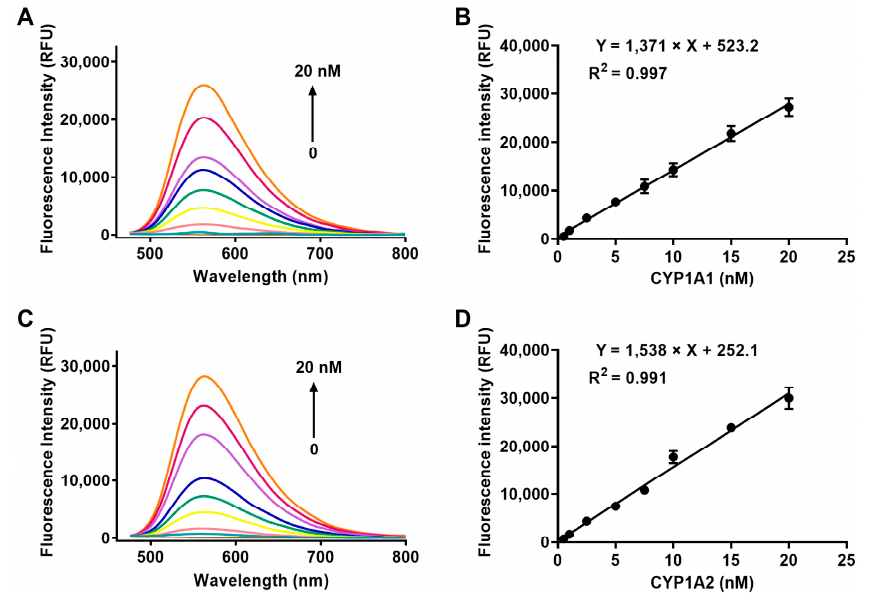
Figure 1. Fluorescence spectra of ERNM that incubated with increasing concentrations of CYP1A1 ( A ) and CYP1A2 ( C ). Fluorescence intensity of ERNM at 558 nm that incubated with various concentrations of CYP1A1 and CYP1A2. λ ex = 450 nm. Data in ( B , D ) are shown as the mean ± SD.